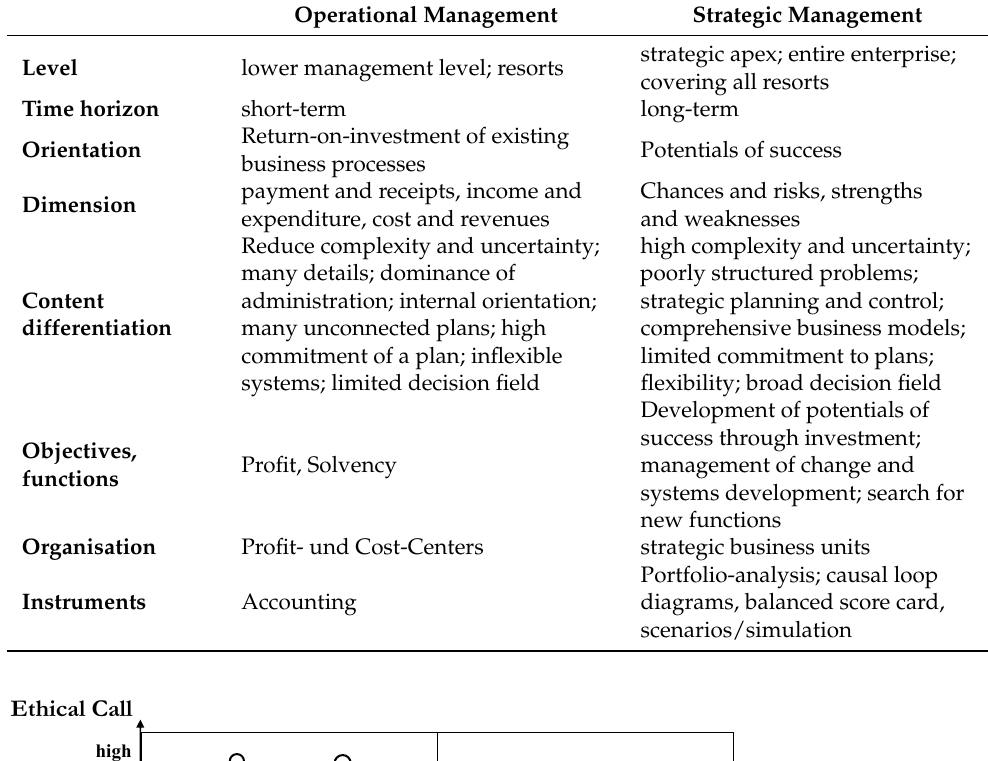
Table 1. Operational and Strategic Management. Source own, adapted from [20].